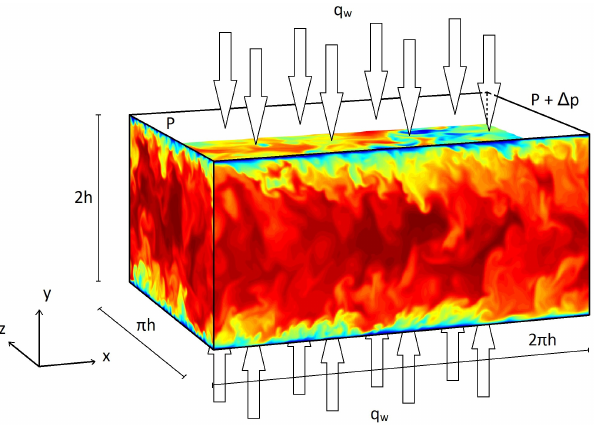
Figure 1. Geometry and instantaneous representation of the temperature